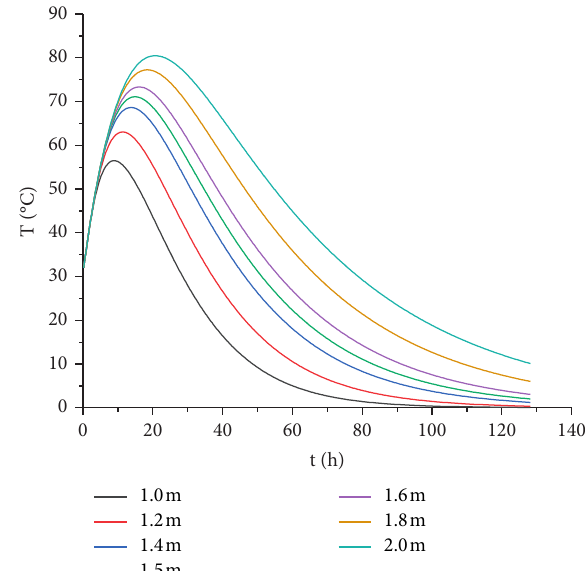
Figure 9: Center temperature curves of various finite element modeled CFST